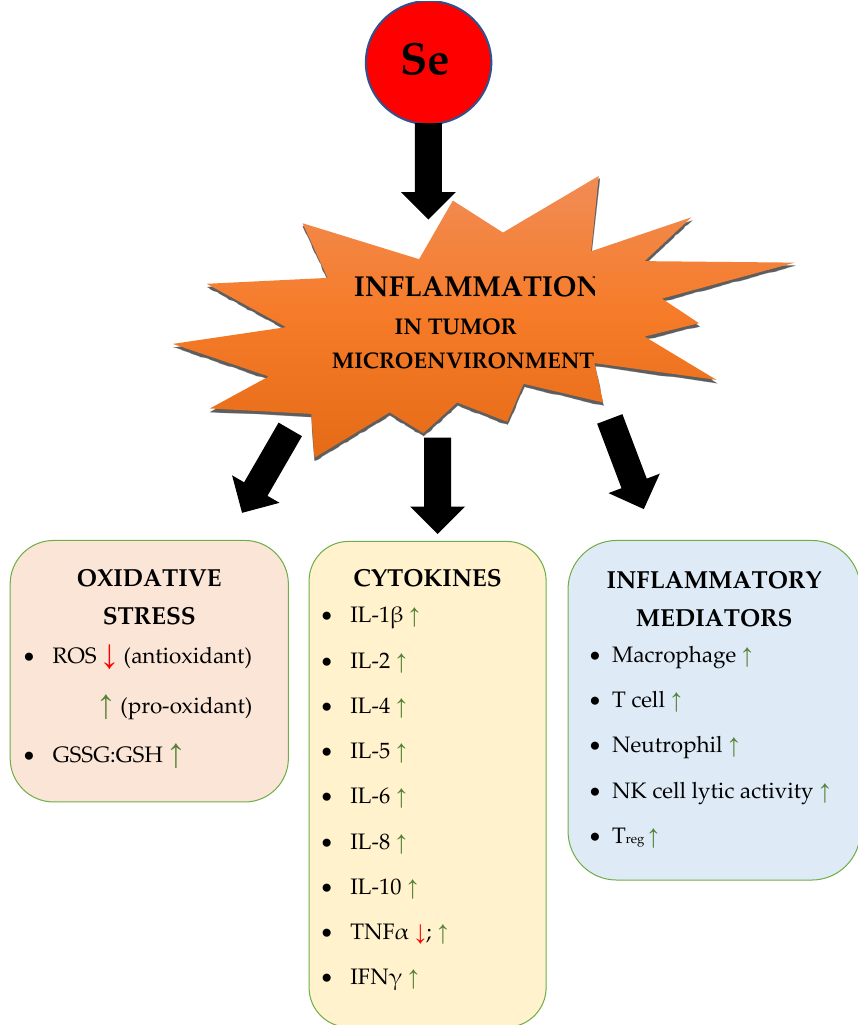
Figure 9. Overview of the influence of Se in the inflammatory tumour microenvironment. A green upward-facing arrow ( ↑ ) indicates that Se has a stimulating effect, while a red downward-facing arrow ( ↓ ) indicates that Se has an inhibiting effect. Abbreviations: ROS — reactive oxygen species; GSSG:GSH — the ratio of oxidized to reduced glutathione; IL —interleukin; TNFα— tumour necrosis factor alpha ; IFNγ— interferon gamma; NK — natural killer [52,119,120,123,132 – 152].